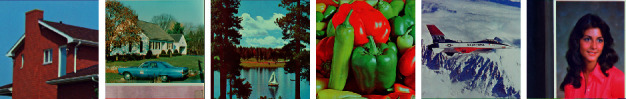
Original color images.